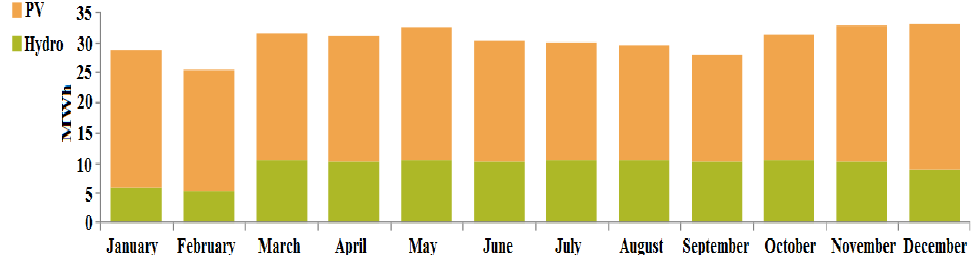
Figure 20. Electrical energy generation on a monthly basis for case III (Ba/H/S).